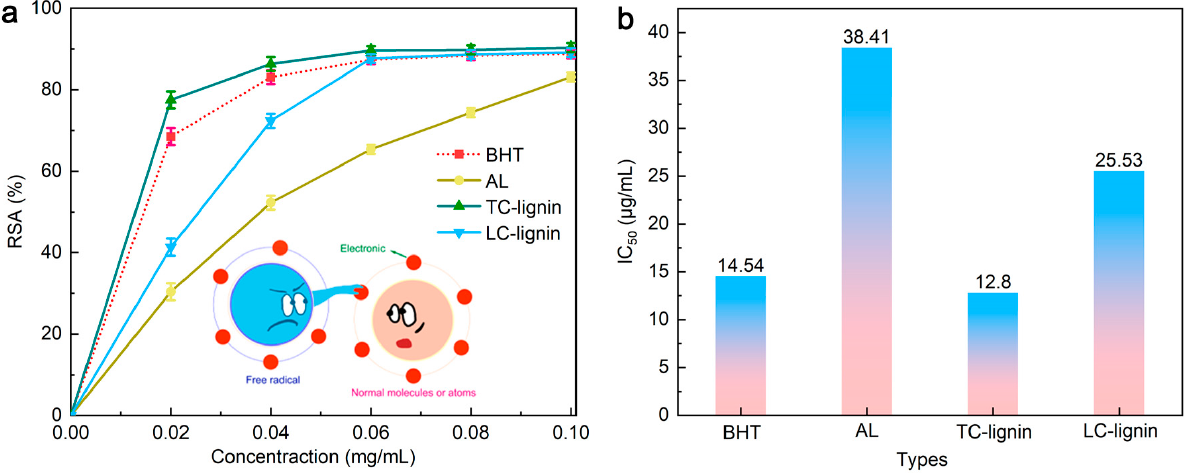
Figure 2. Antioxidant properties of samples ( a ) BHT, AL, LC-lignin, and TC-lignin DPPH· radical scavenging rate and ( b ) antioxidant type and DPPH· radical scavenging ability IC 50 relationship.